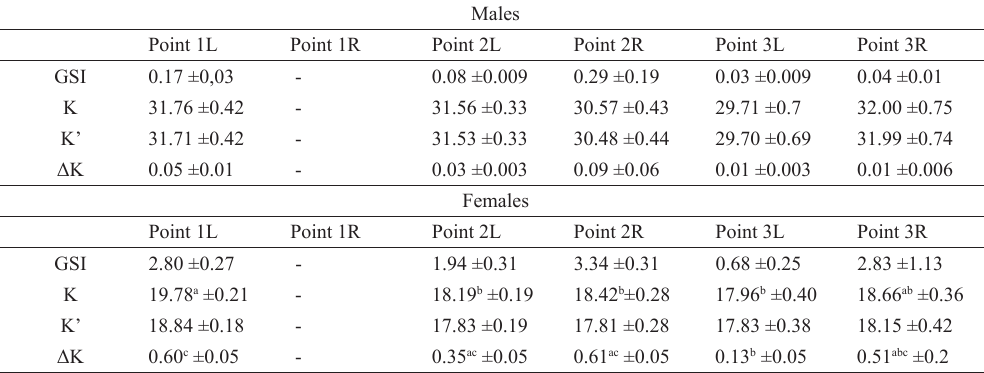
Fig. 8. Bimonthly variations in the total ( K ) and somatic ( K´ ) condition factors for Loricariichthys melanocheilus females in the rio Ibicuí, Rio Grande do Sul. (DJ = December/January, FM = February/March, AM = April/May; JJ = June/July, AS = August/September, ON = October/November). Table 3. Gonadosomatic Index (GSI), Total Condition Factor ( K ), Somatic Condition Factor ( K’ ), Gonad Condition Factor (ΔK) and his standards deviation of Loricariichthys melanocheilus in rio Ibicuí by points of collection. (1R, 2R and 3R = Points 1, 2 and 3 in the river; 1L, 2L and 3L = Points 1, 2 and 3 in lagoons). *Different letters in rows indicates significance (p <